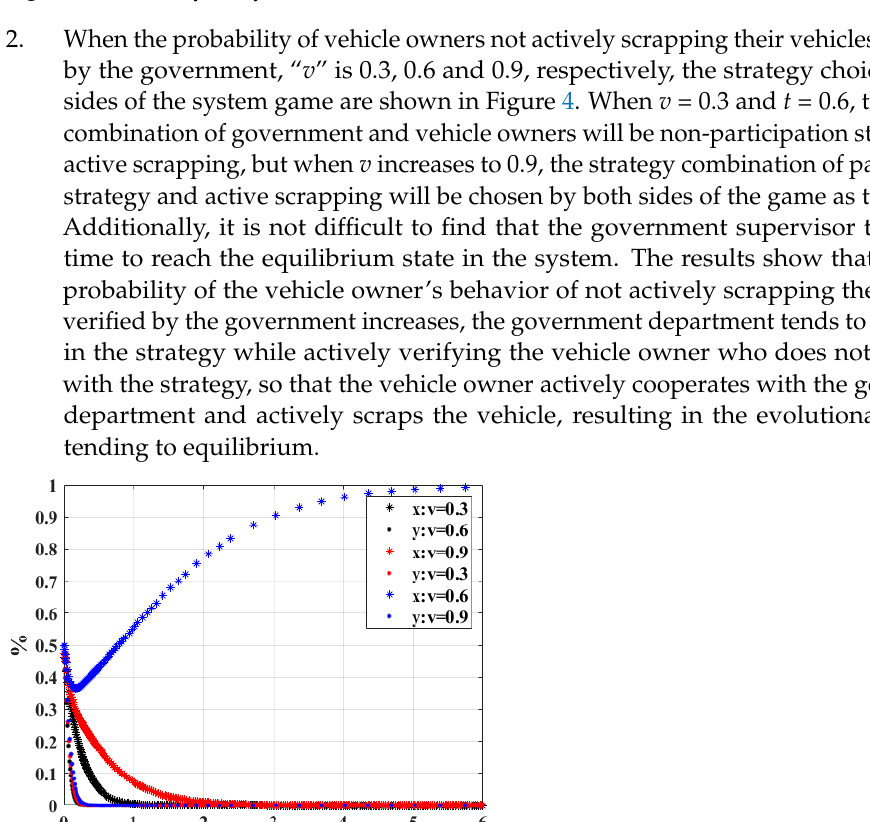
Figure 3. Sensitivity analysis of “ t ”.